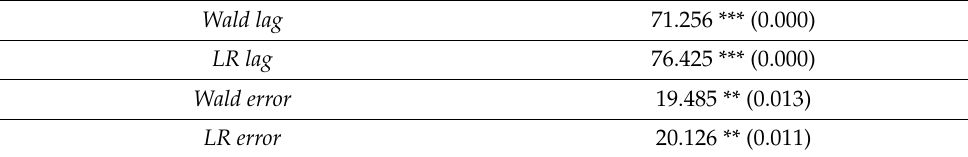
Table 4. Wald test and LR test for spatial Durbin model.